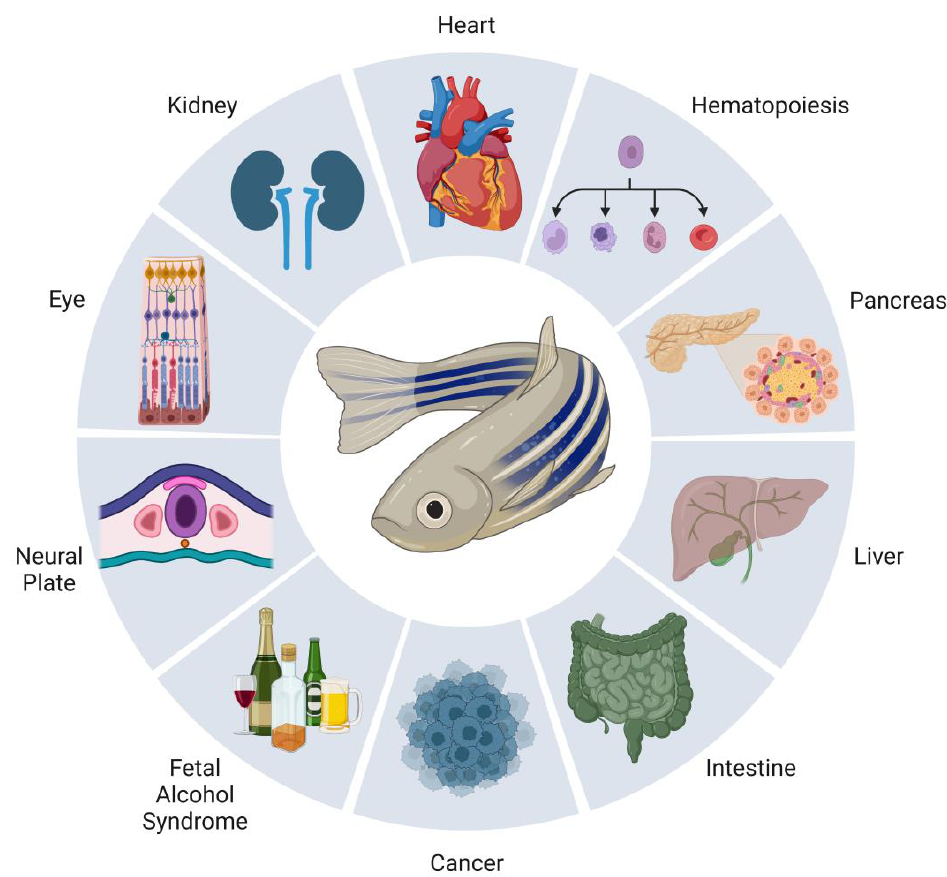
Figure 4. Summary of zebrafish models of RA signaling in development and disease. Research using the zebrafish has been a powerful good for realizing new insights into the development of many tissues and organs. Numbering among them, and discussed in the present work, are the neural plate, eye, kidney, heart, blood, pancreas, liver, and intestine. Many others have been studied as well [17]. Our understanding about the teratogenic effects of RA in conditions such as fetal alcohol syndrome and its role in cancer have also been expanded through the use of zebrafish. Figure created with BioRender.com [232].